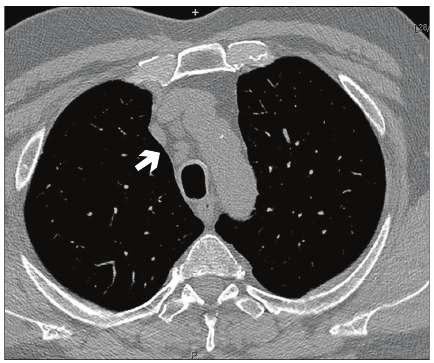
Figure 2: Mediastinal lymphoadenopathies (arrow).